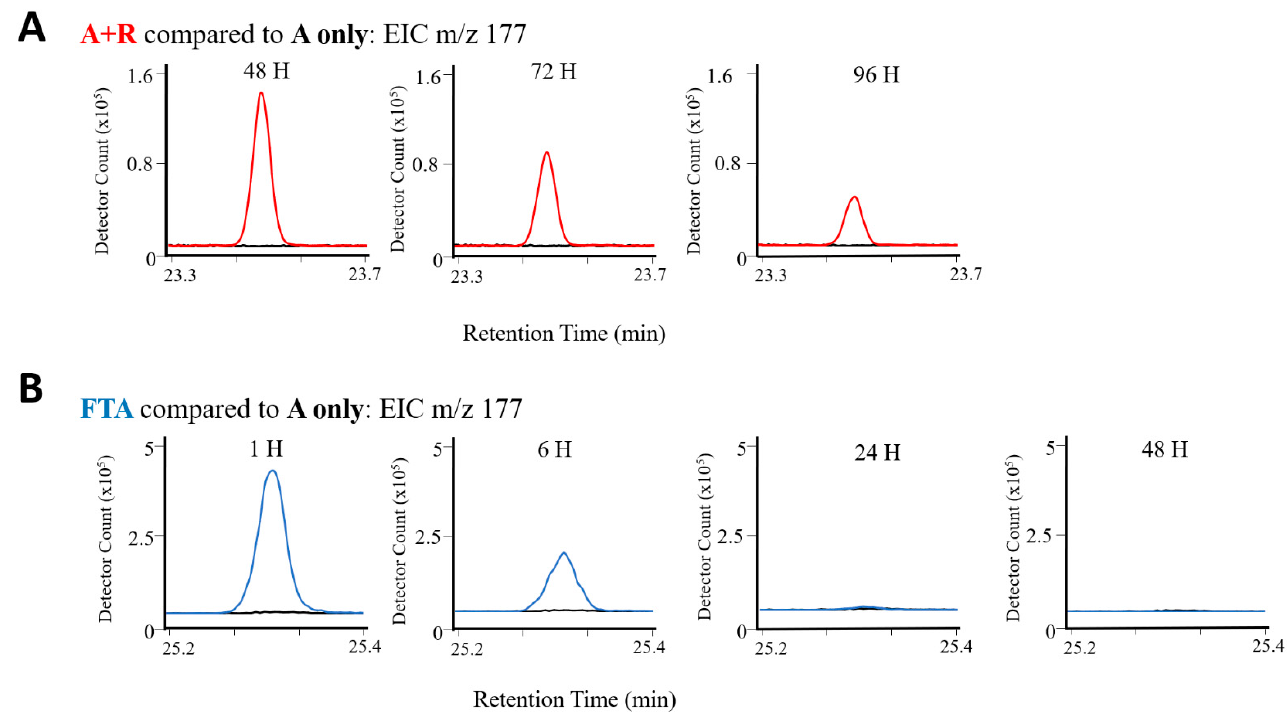
Figure 2. Example extracted ion chromatograms for m/z 177 for putative biomarker, β -ionone, observed in both rotifer- grazed M. gaditana (A + R, red) and time-matched healthy algae controls (A only, black) in part ( A ) and freeze–thawed M. gaditana (FTA, blue) with time-matched healthy algae controls (A only, black) in part ( B ) throughout the duration of condition-specific timepoints measured during each experiment.